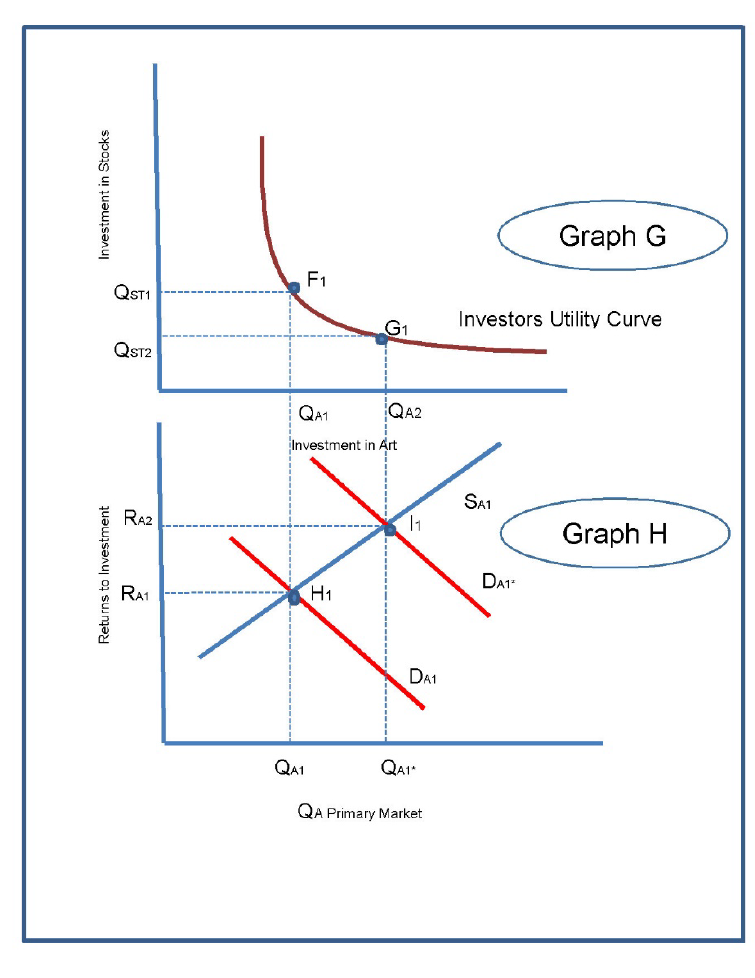
FIGURE 5: Alternative investments and the return to investors for ‘Fine Art’ Source: Authors’